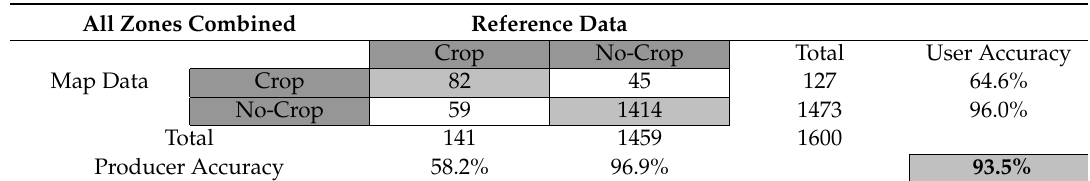
Table 4. An overall accuracy matrix for the cropland extent map of